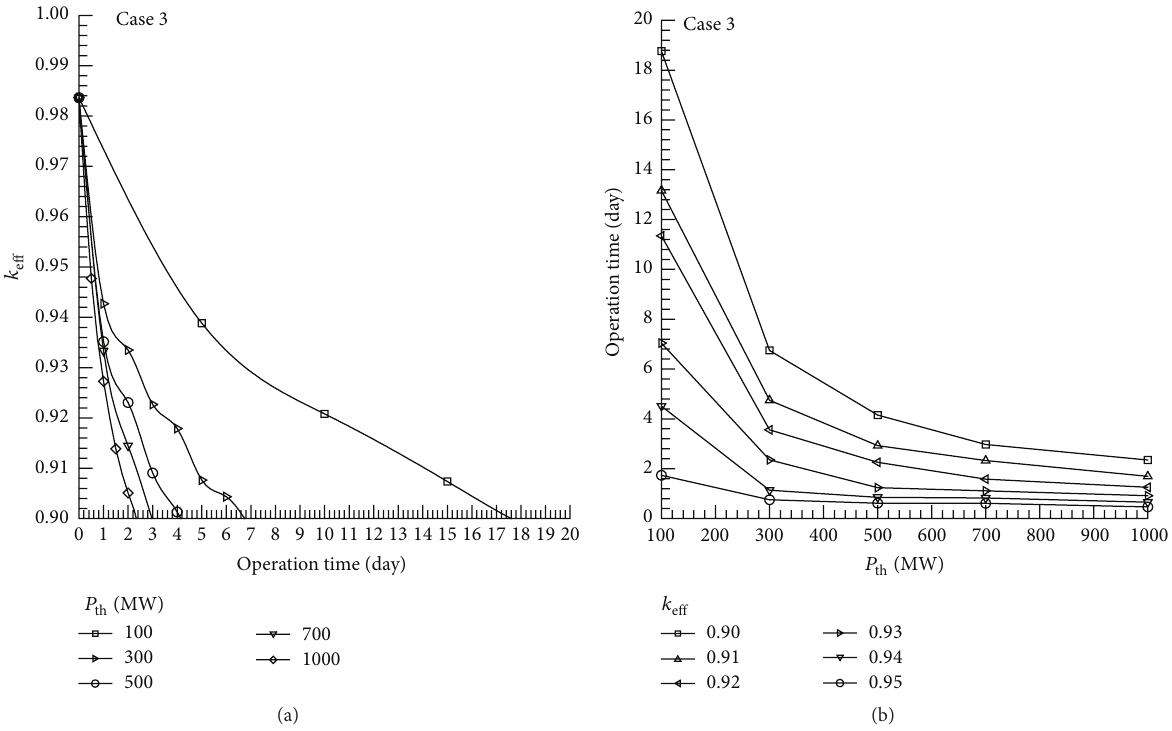
Figure 6: (a) Variations of the effective neutron multiplication in the various cases of thermal power depending on the operation time. (b) The operation time at which effective neutron multiplication reached various values (0.90–0.95) versus the thermal